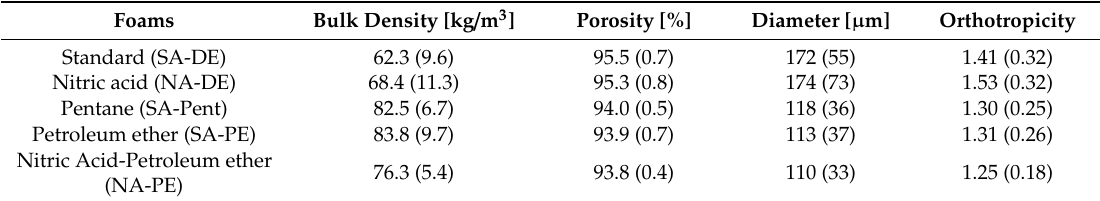
Table 2. Bulk density, porosity average diameter, and orthotropicity of the tannin-based foams. Foams